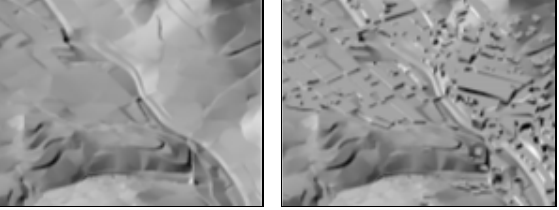
Fig 3: Elevation data from BT-5M, DTM at the left and DSM at the right Data are distributed as geoservices and in several CAD, GIS and raster formats, including KMZ for